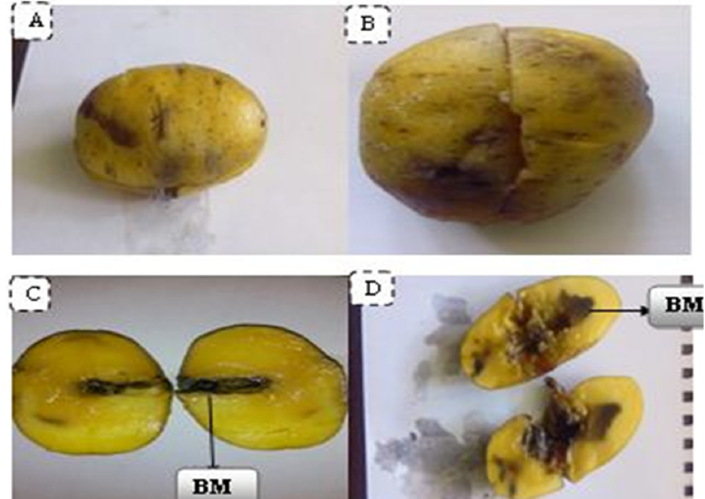
Figure 2. Scurfy Irish potato. Irish potato inoculated with R. solani after 5 days (A), 10 days (B), 18 days (C) and 28 days